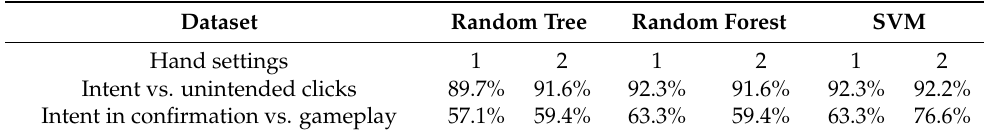
Table 5. Classification results on Dataset 1 for training.